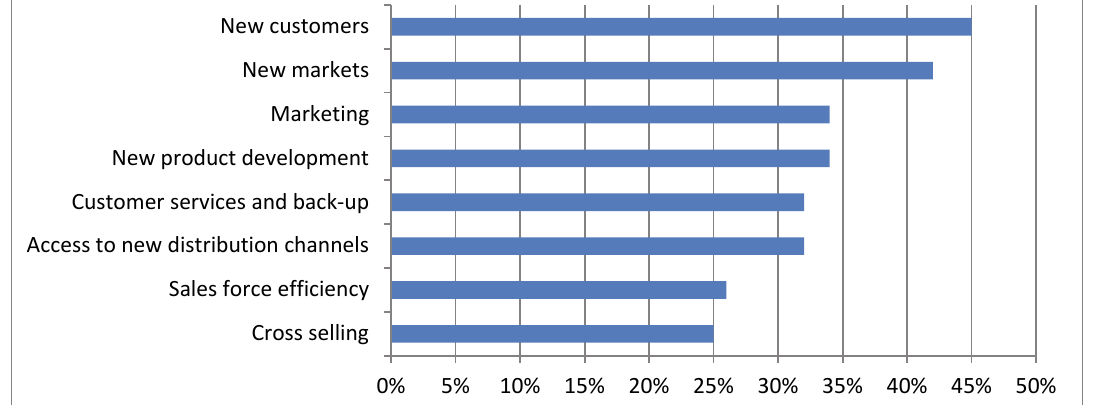
Fig. 2. Areas for increasing revenue